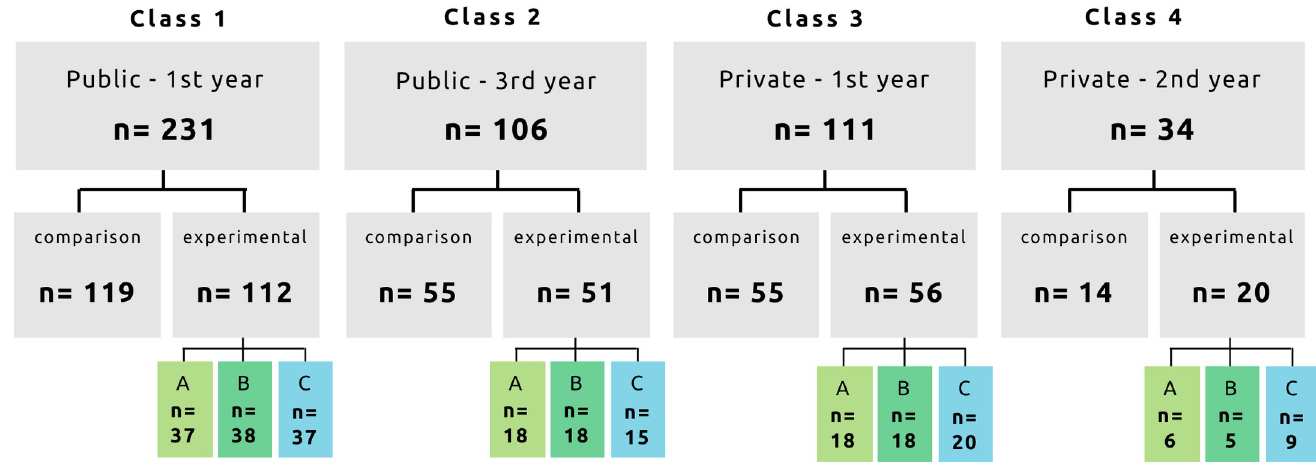
Fig 2. Distribution of study participants for the quantitative component (n = 482). Group A–video 1 journalistic; Group B–video 2 dramatic; Group C–video 3 animation.